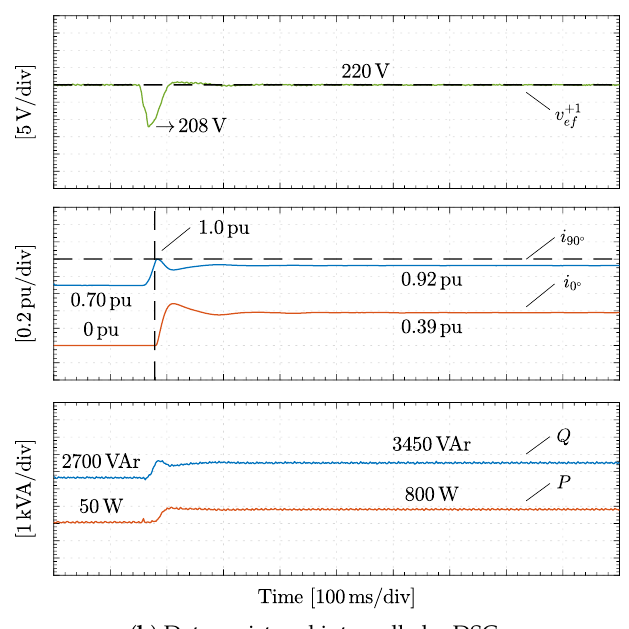
Figure 15. Experimental results for load change: ( a ) Converter currents and PCC voltage for load increase; ( b ) Waveform of positive sequence effective voltage, quadrature and phase current references, and converter injected power to load increase.